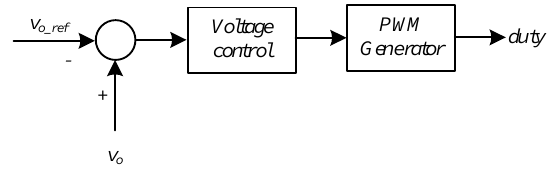
Figure 7. Control diagram for the full-bridge inverter.